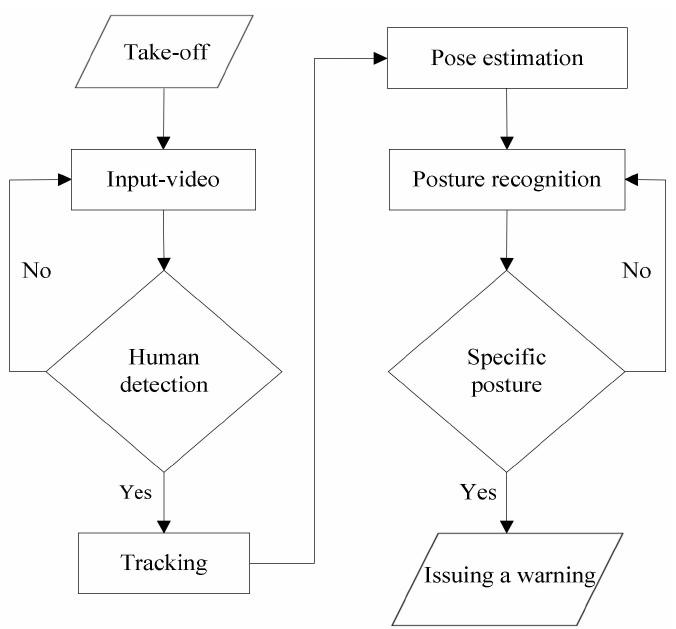
Figure 1. The scenario of the proposed system.